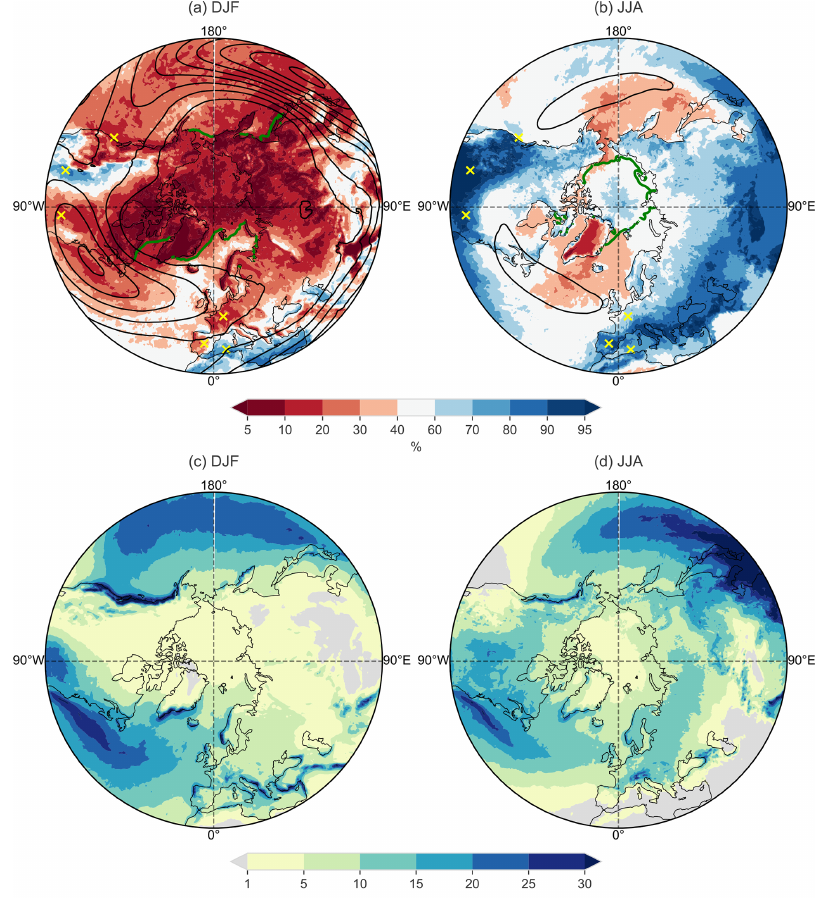
Figure 2. Fraction of wet days below the median of the local 2m temperature distribution (WBM measure, see Sect 2.1) in (a) winter (DJF) and (b) summer (JJA). Yellow crosses indicate the locations of the regions analysed later in this study, black contours show wind speed at 300hPa starting from 25ms − 1 in 5ms − 1 increments, and the green contour marks the climatological sea ice concentration of 50%. Panels (c) and (d) illustrate the seasonal 95th percentile of daily accumulated precipitation for DJF and JJA,